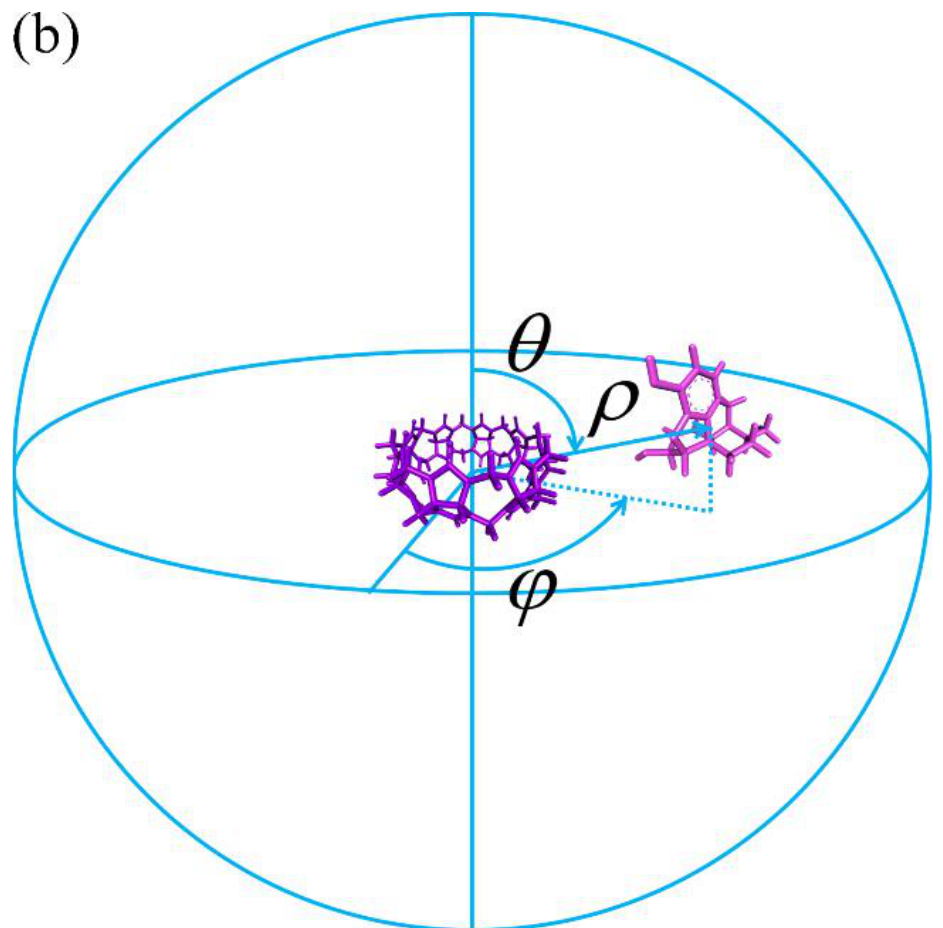
Figure 1. ( a ) The 3D structure of the CB8 host and the 2D chemical structures of its 7 guests. For the guest G5 Ketamine, due to the small difference between the experimental and ChemAxon predicted pKa and the pH condition that the binding affinity is measured, both the protonated and deprotonated forms of the guest G5 are considered in our modelling. ( b ) An illustration of the 3D spherical coordinates CV used to bias the simulation.